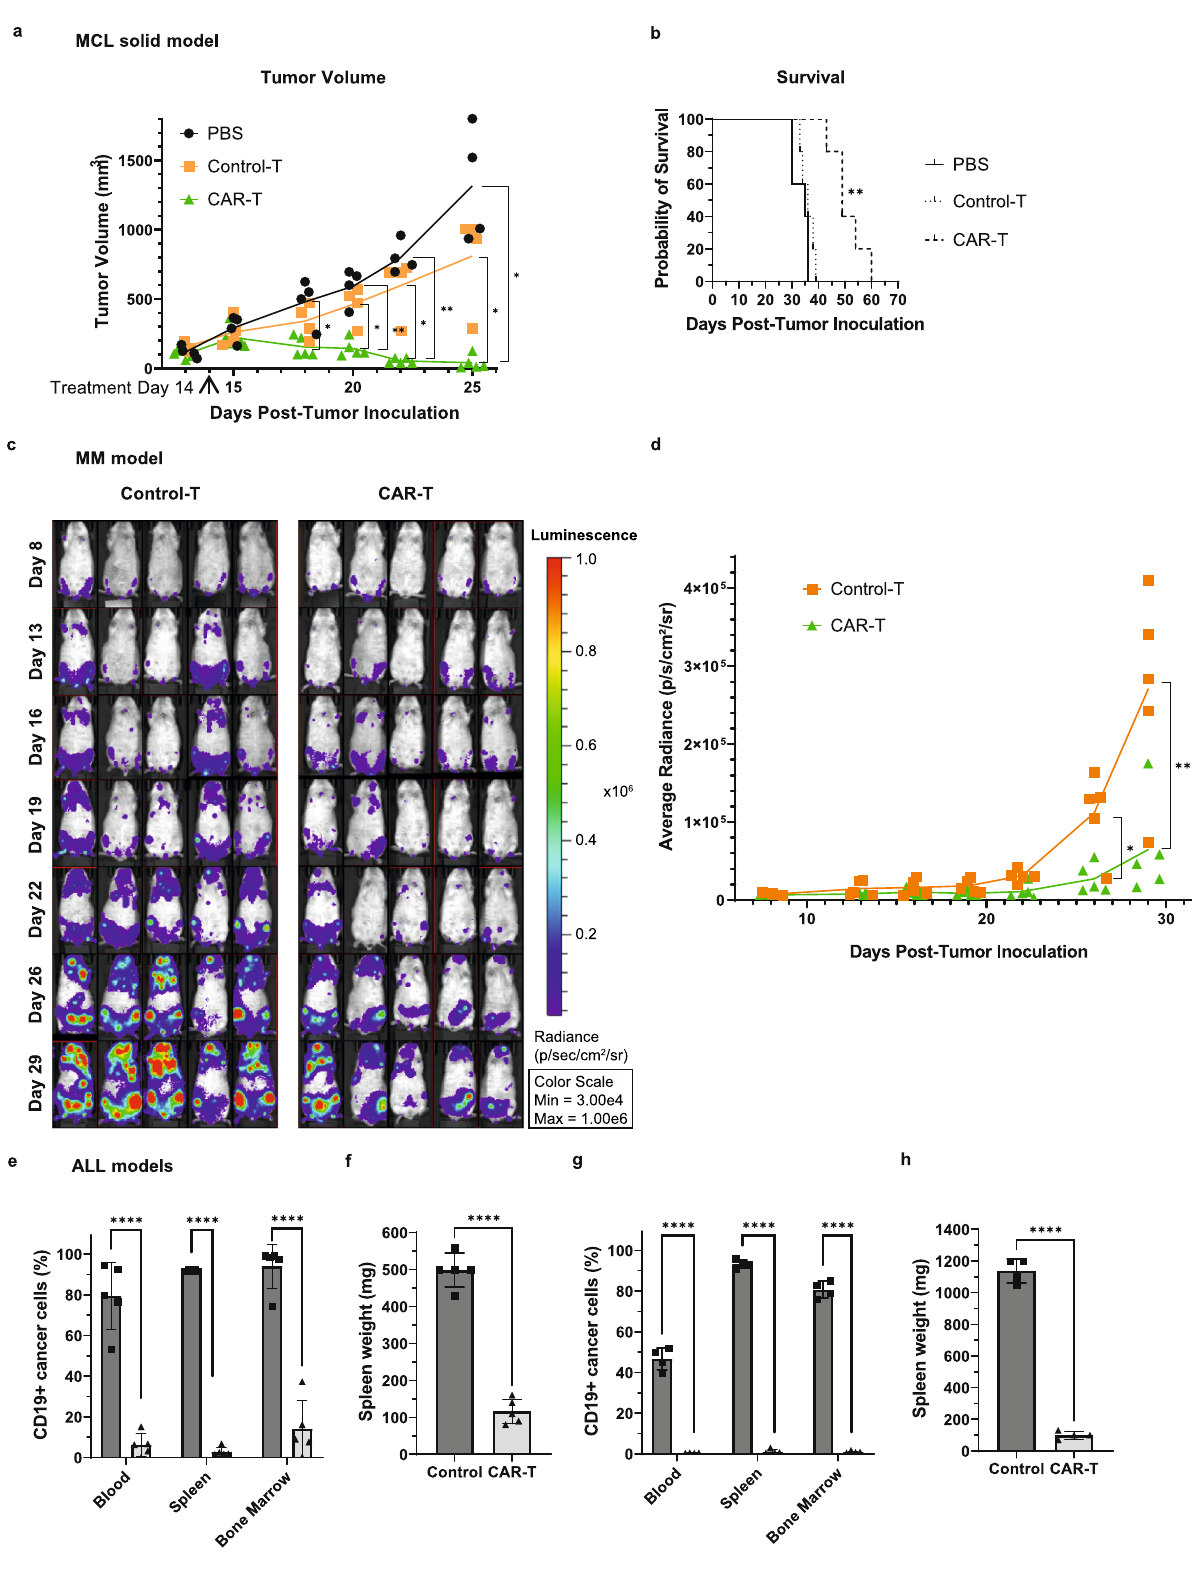
Droplet digital PCR for copy number analysis . Genomic DNA was harvested from expanded T cell samples using the Qiagen QIAamp DNA Blood Mini kit per manufacturer ’ s instructions (Qiagen, Hilden, Germany). Integration PCR was run as a duplexed assay consisting of an internal reference RNAse P primerand probe set (HEX) and an experimental primerand probe set (FAM) designed to target either the promoter of the transgene or the junction between the promoter and